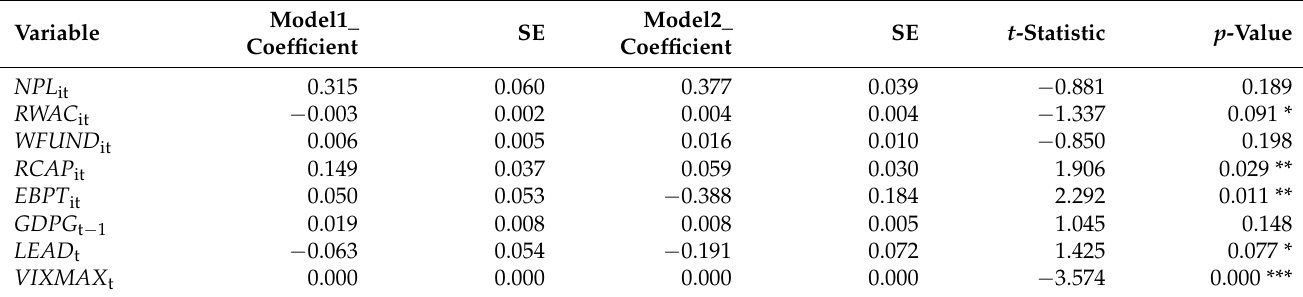
Table A15. Comparison of crisis (3) and post-crisis (5).